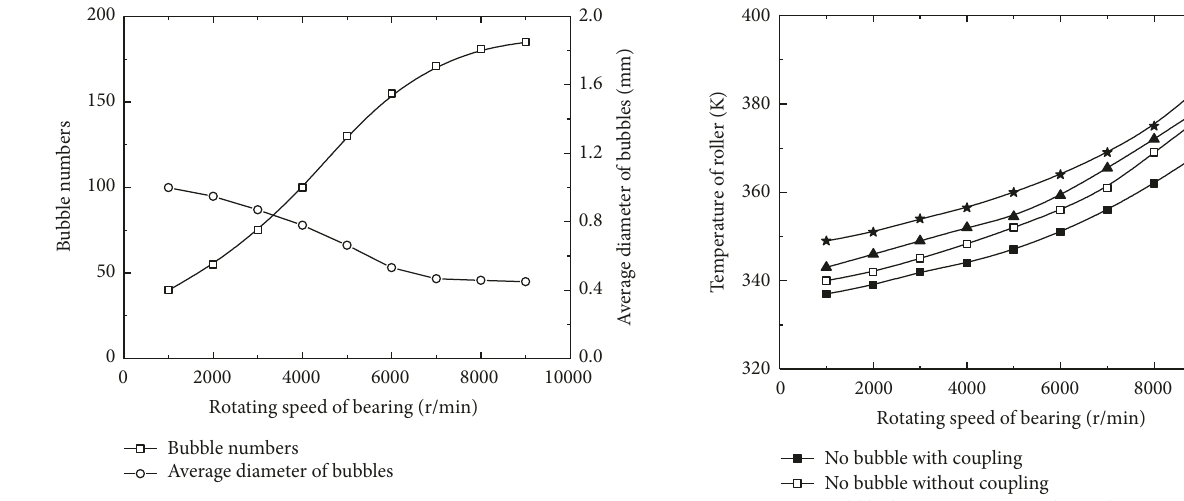
Figure 9: Bubble number and diameter varying with rotating speed.